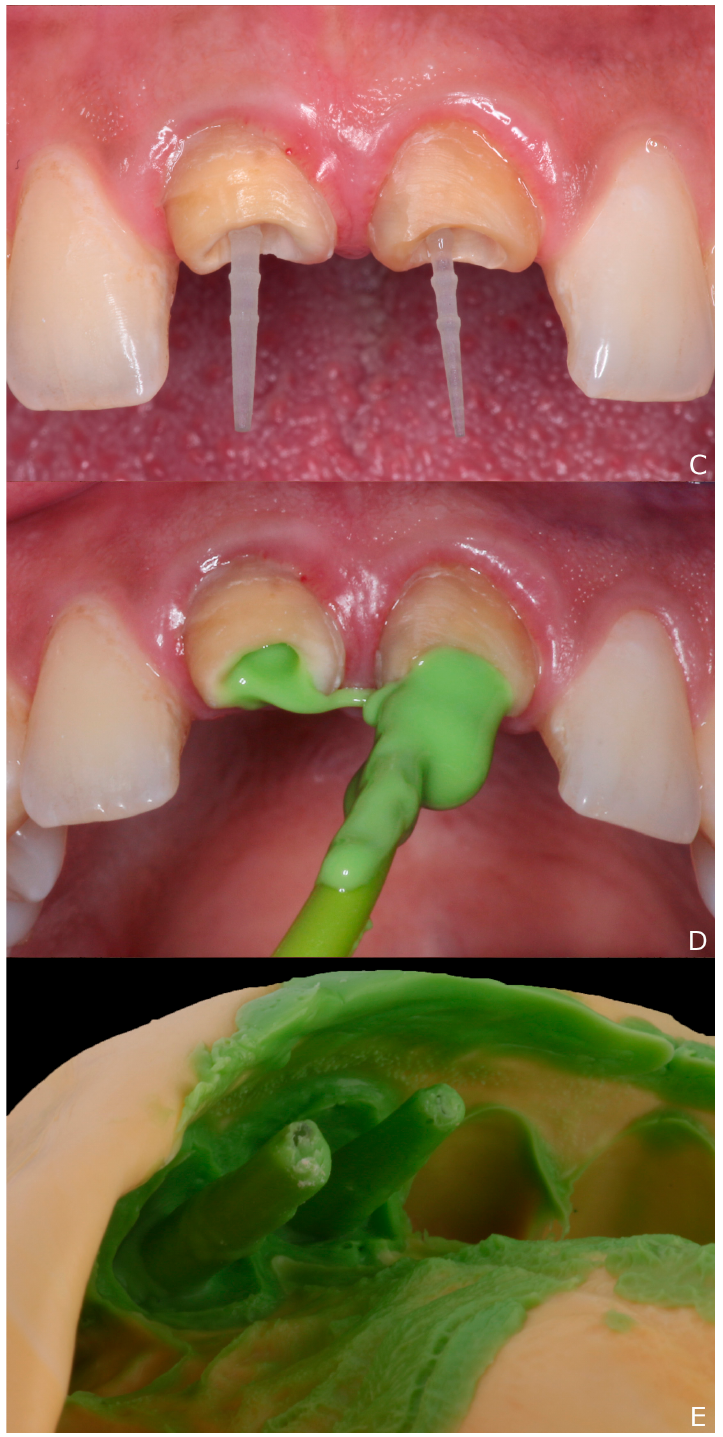
Figure 3. Steps of custom ‐ made post impression: ( A ) drilling with post drill; ( B ) the canals after drilling; ( C ) plastic posts try ‐ in to check the passive fit inside the canals; ( D ) injection of light body drilling; ( C ) plastic posts try-in to check the passive fit inside the canals; ( D ) injection of light impression material inside the canals; and ( E ) final impression for custom ‐ made post and core.